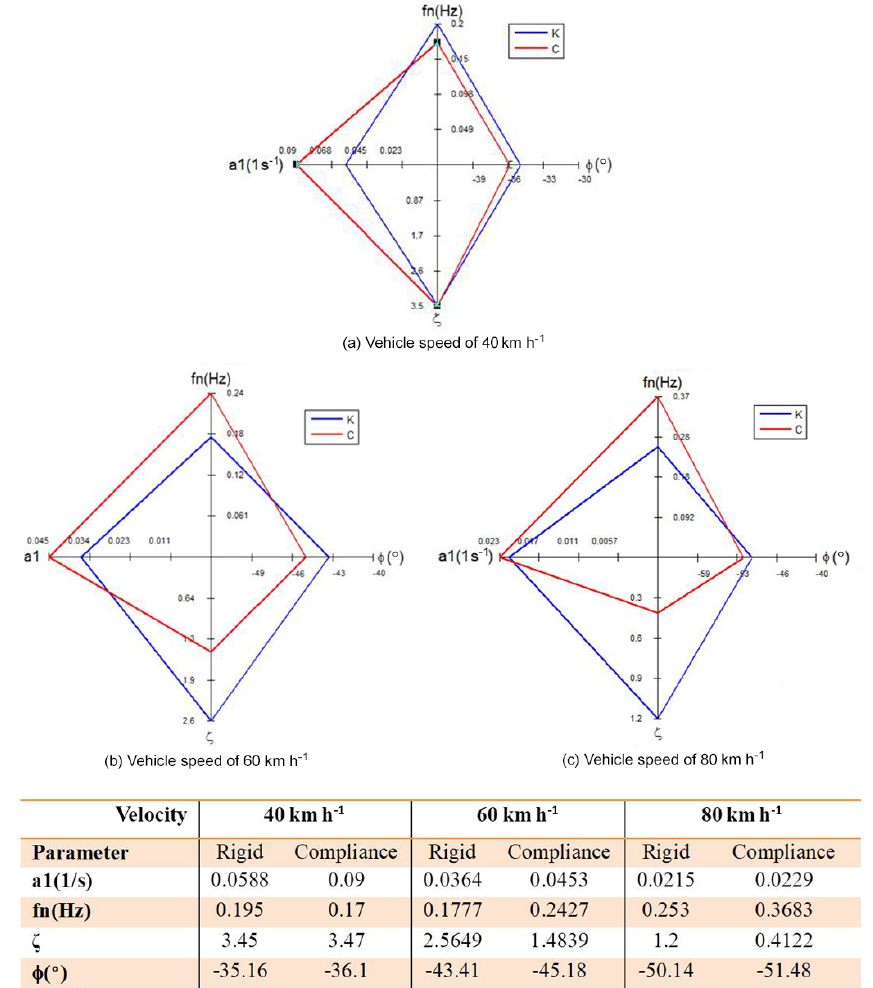
Figure 14. Radar plots for different